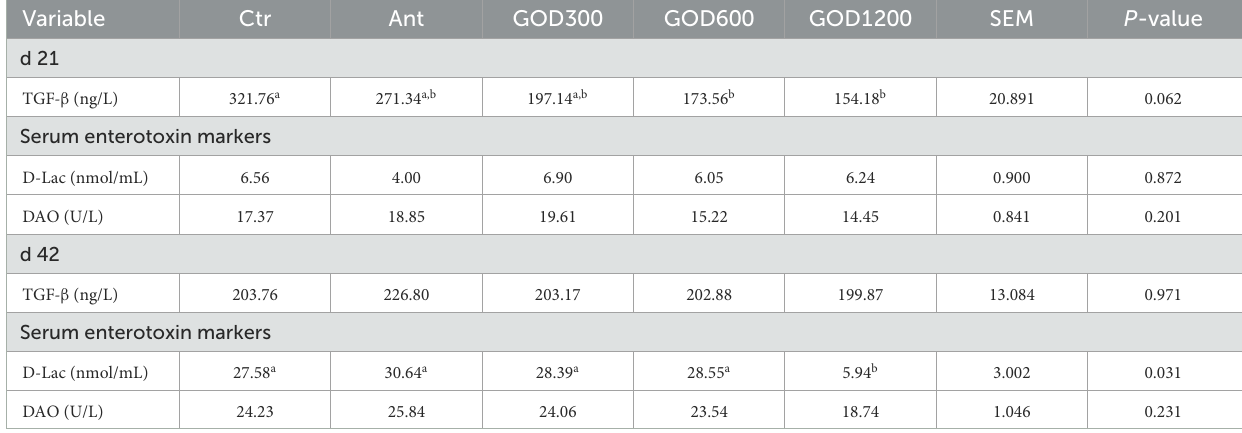
TABLE 6 Effect of GOD on cytokine parameters and serum markers of broilers in serum (mean ± SEM, n = 6). Variable